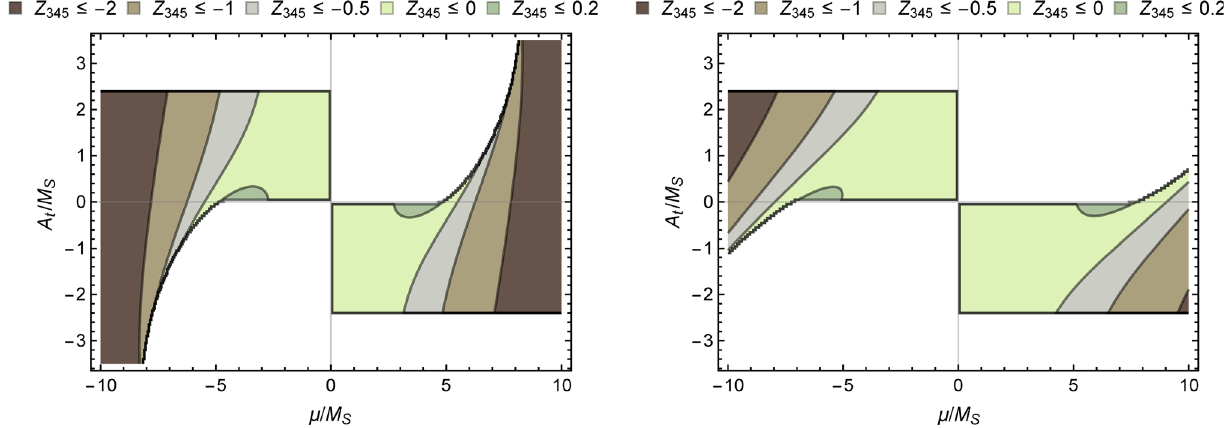
panels of Fig. 3 in the (μ/ M S , A t / M S ) plane. Left: Approximate one- loop result; right: two-loop improved